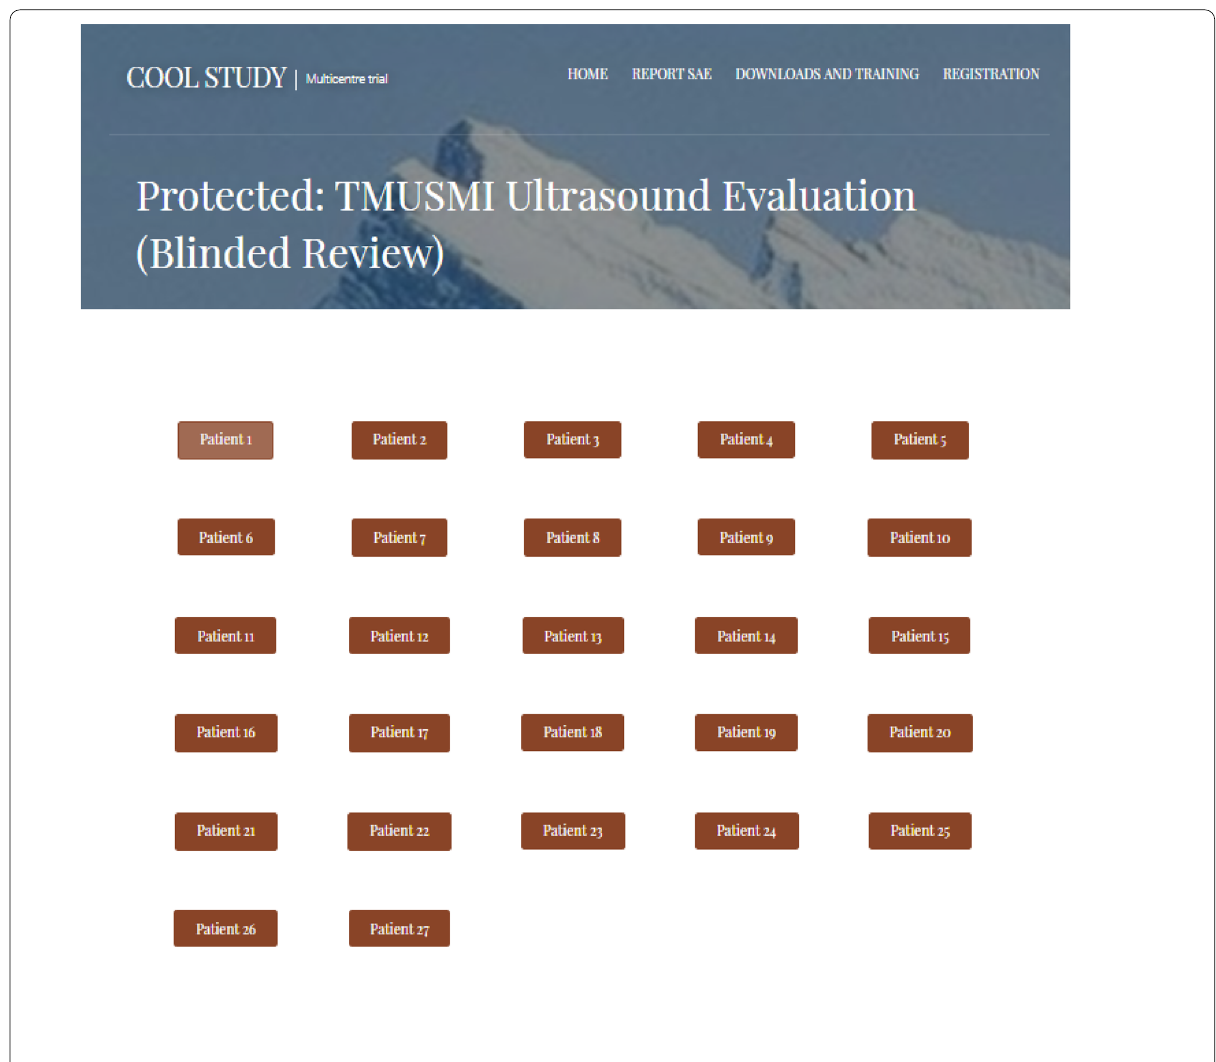
Fig. 5 Webpage of selected still images and full video recordings of each examination for blinded review. Some individual Participants have consented to the public disclosure of their personal images, while others have not. Thus, despite the large amount of documentation available in the public domain, all the data available to the original reviewers is not available here due to confidentiality considerations. Videorecording of the complete examinations for those subjects who agree to disclose their personal images are available in Additional file